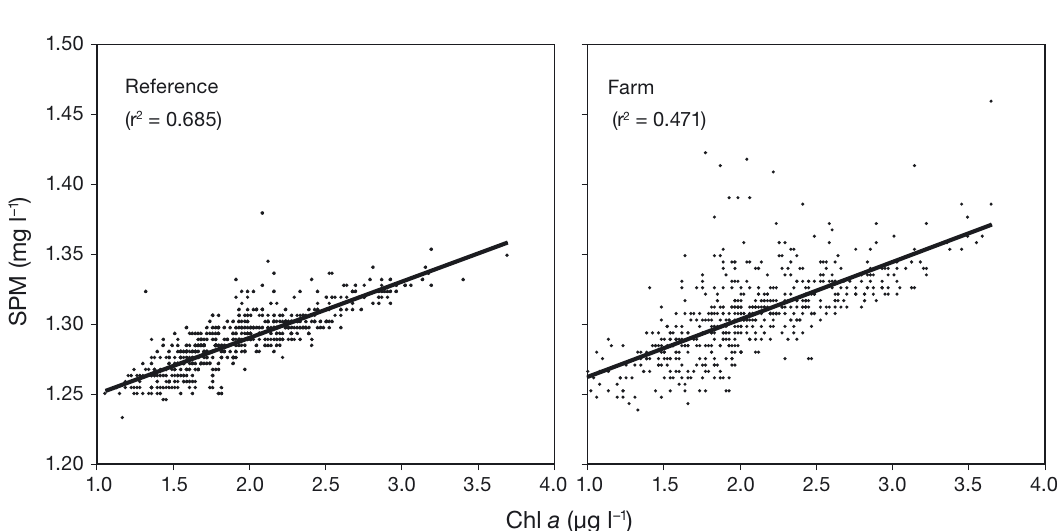
Fig. 6. Relationships between chlorophyll a (chl a) and suspended particulate matter (SPM) concentrations at 5 m depth at the Flåtegrunnen farm and reference stations (Fig.